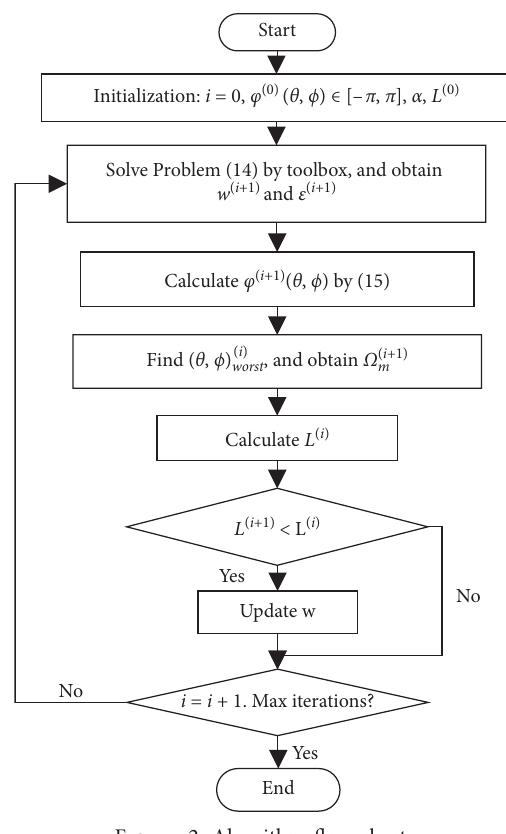
Figure 2: Algorithm flow